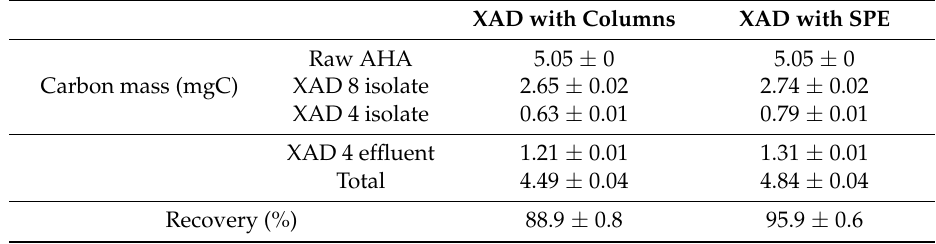
Table 2. Carbon mass balance of AHA through combined XAD 8/4 isolation with columns and with SPE cartridges.